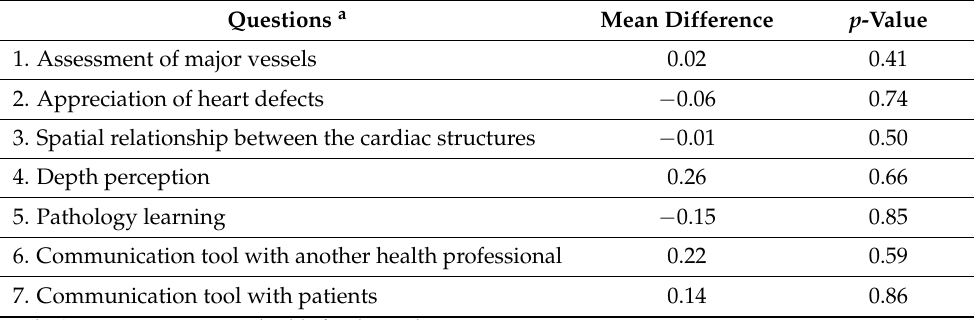
Table 4. Mean differences in responses between interventionalists and